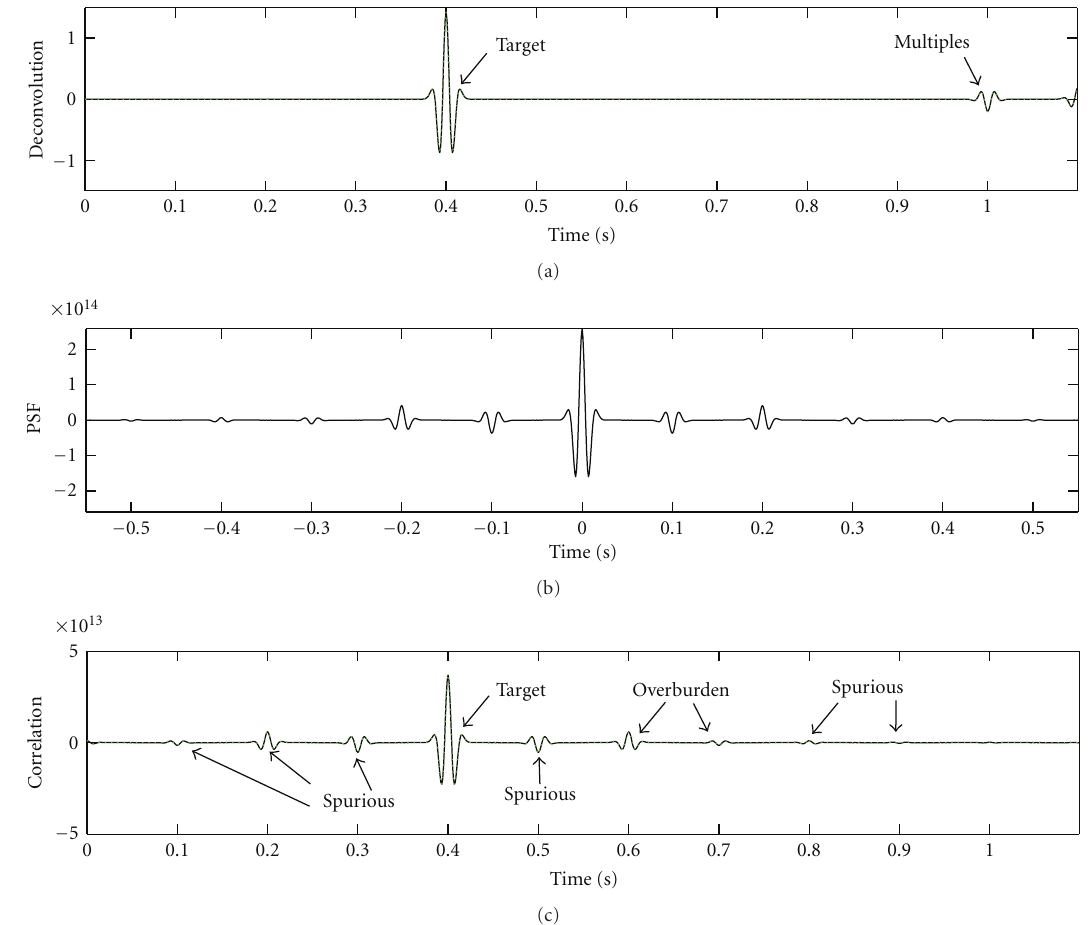
Figure 15: Deconvolution of perturbed fields for model D: (a) retrieved Green’s function (black) and the reference response (dashed green); (b) point spread function Γ ptb ; (c) convolution of the reflection response with the PSF (black) and the correlation function C ptb (dashed